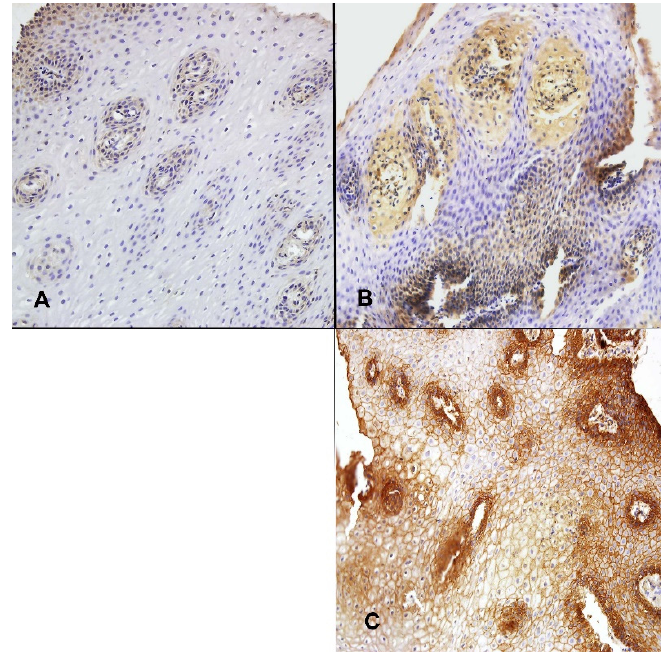
Figure 4. The expression of EGF and EGFR in squamous epithelium evaluated by immunohistochemistry. ( A )—low EGF expression (positive in less than 33% of vessels and no reaction in squamous epithelium) (magn. ×200); ( B )—high EGF expression (positive in over 66% of vessels and positive reaction in more than a half of the thickness of the squamous epithelium) (magn. ×200); ( C )—high EGFR expression (positive in over 66% of vessels and positive reaction in more than a half of the thickness of the squamous epithelium) (magn. ×200). There were no cases with low EGFR expression in the study group.